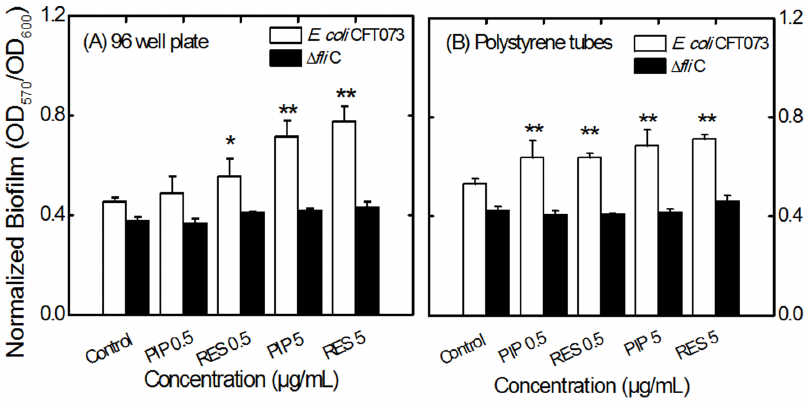
Figure 3. Effect of PIP and RES on 48 h biofilm levels of E.coli CFT073 (white bars) and the flagellar mutant E.coli D fli C (black bars) in (A) 96 well plates and (B) polystyrene tubes. The biofilm values (OD 570 ) were normalized with respect to growth (OD 600 ). Abbreviations: PIP 0.5 or RES 0.5, piperine or reserpine at 0.5 m g/mL ( e.g. , PIP 0.5 indicates piperine at 0.5 m g/mL). Values shown denote the mean + SD for three experiments. * and ** indicate statistically significant differences with respect to the control with values p , 0.05 and p , 0.01,